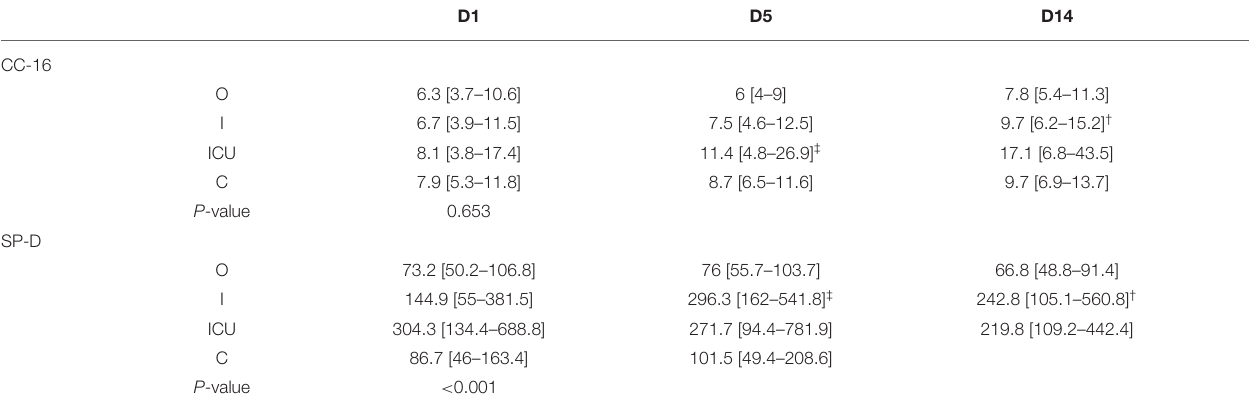
TABLE 2 | Temporal profiles of CC-16 and SP-D according to the group.